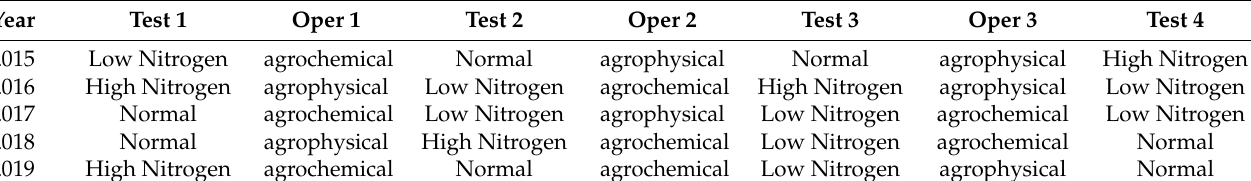
Table 3. Structure of the illustrative dataset from the example.